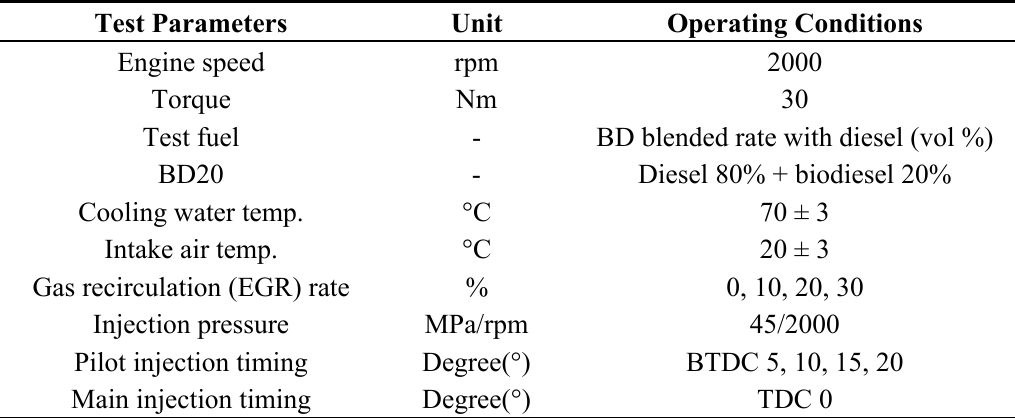
Table 2. Experimental and operating